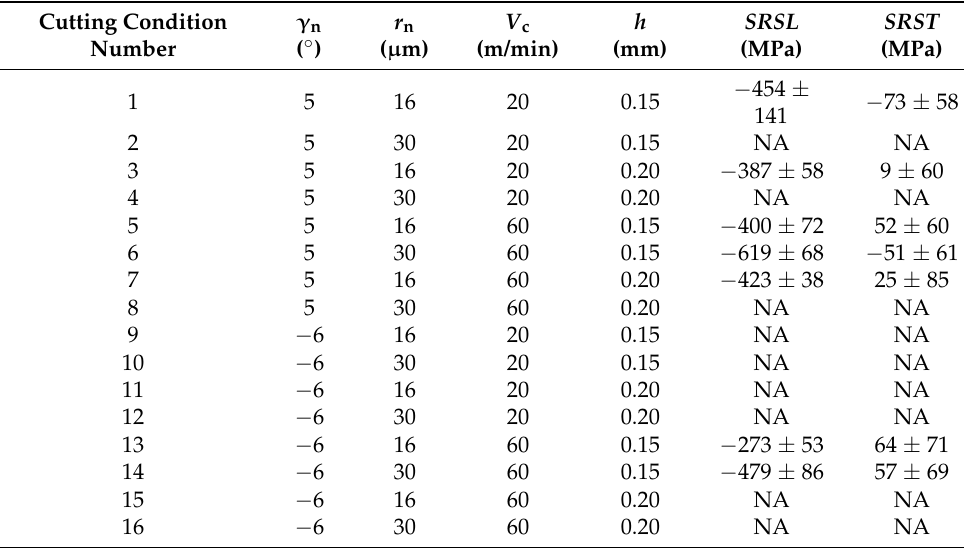
Table 8. Experimental results of the residual stresses at the machined surface. Cutting Condition